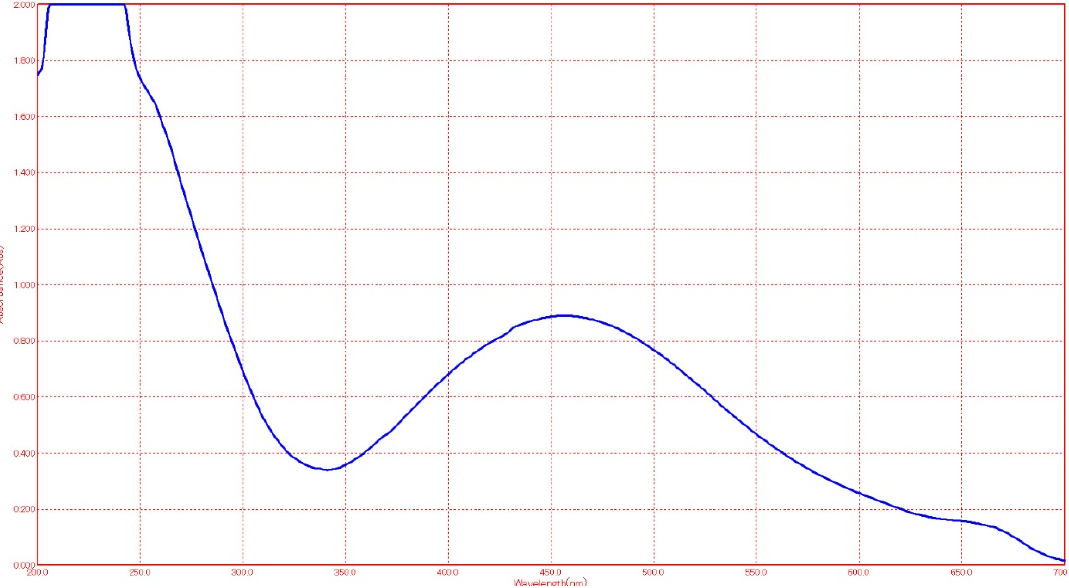
Figure 1. The silver surface plasmon resonance band as seen under UV-Visible spectra. The peak appears at 450 nm.